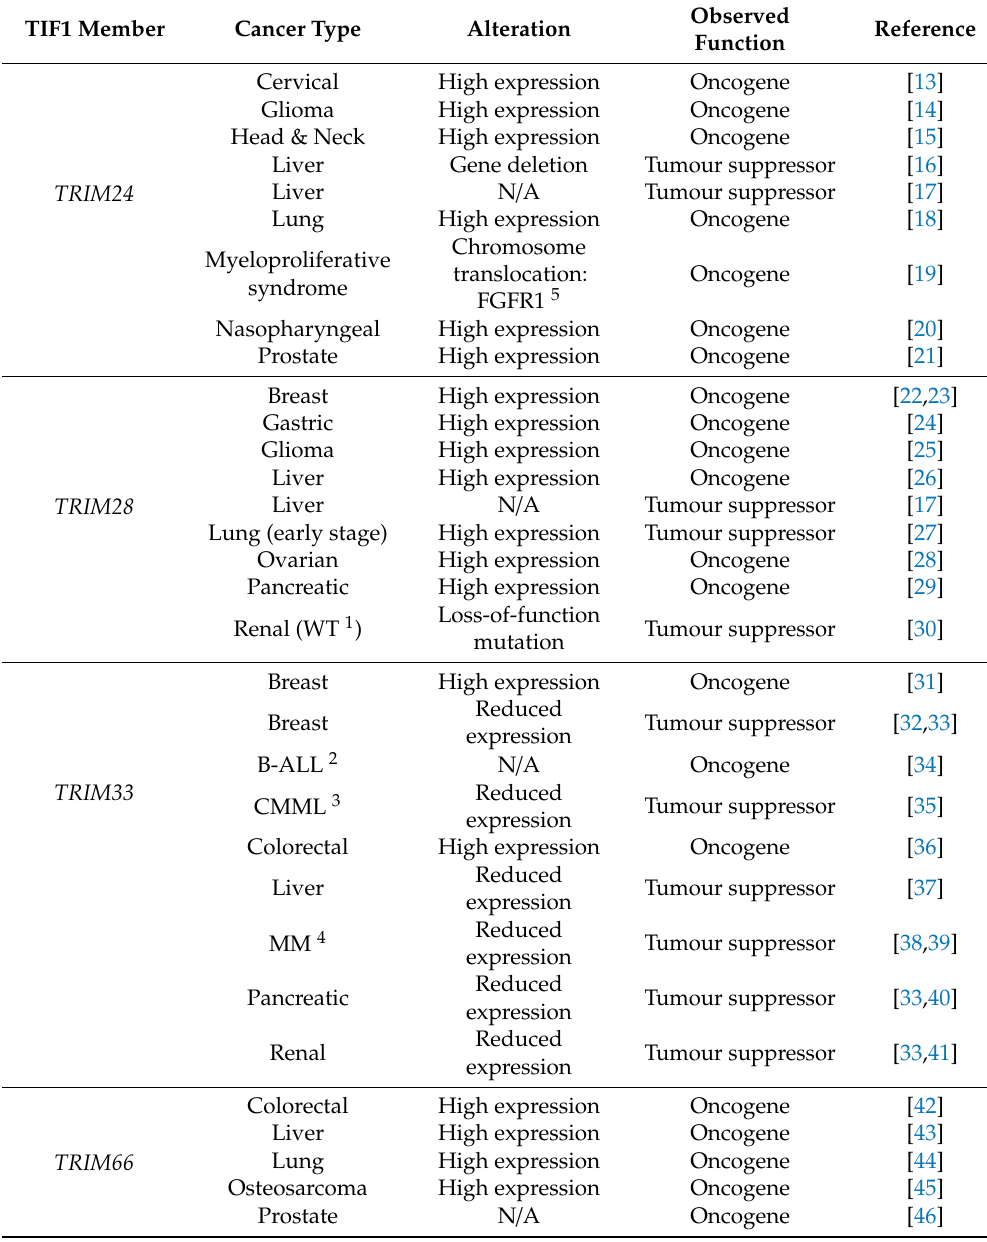
Table 1. Alterations in the TIF1 family members in cancer, and the proposed function of that gene on cancer progression. 1 WT—Wilms’ tumour; 2 B-ALL—B-cell acute lymphoblastic leukaemia;